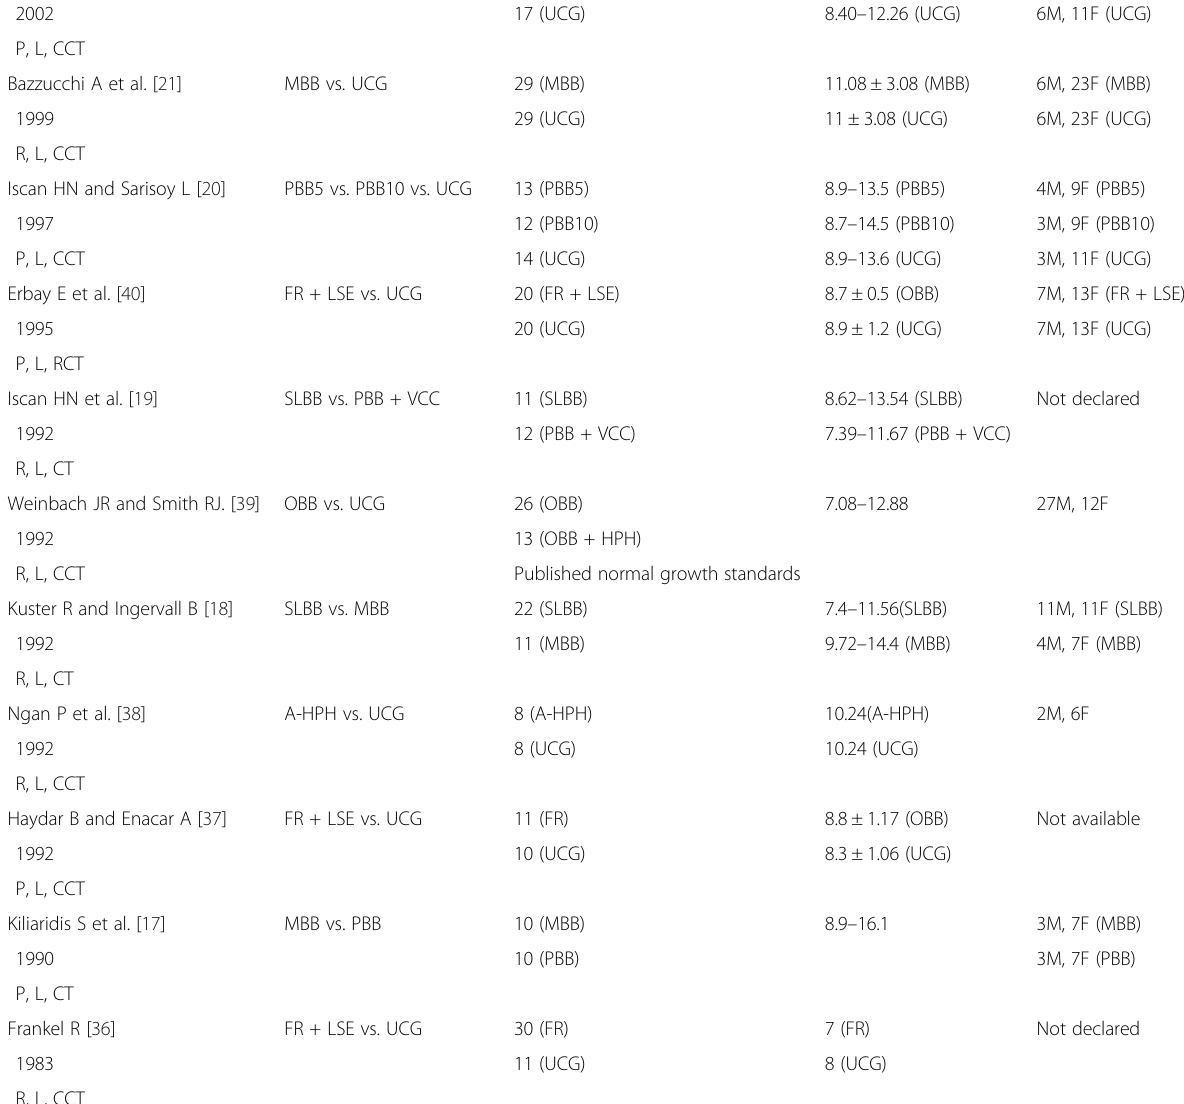
Table 1 Results: trial design, treatment modalities, characteristics of the samples (Continued)